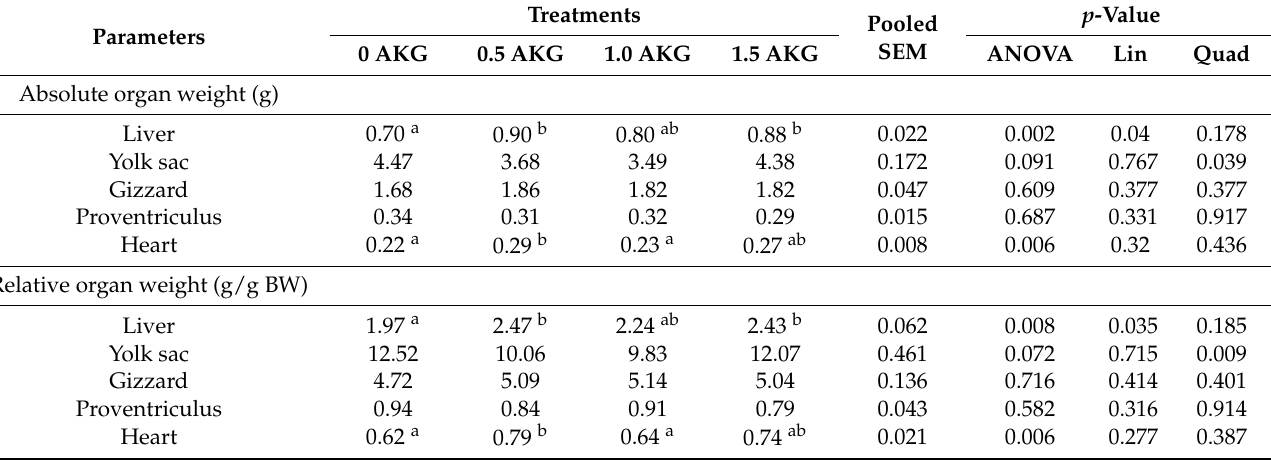
Table 3. Effects of in ovo feeding of α -ketoglutaric acid (AKG) on the absolute and relative organ weights of the gizzard, heart, liver, proventriculus, and yolk sac in chicks at hatching